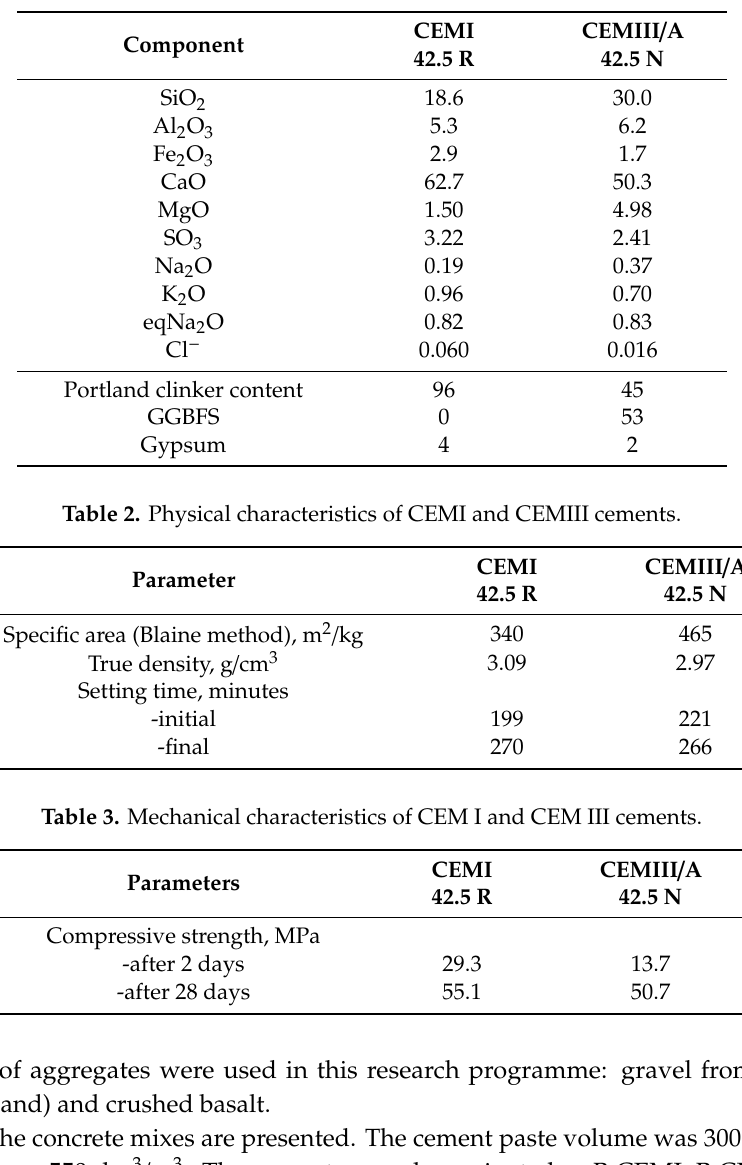
Table 1. The chemical characteristics of CEM I and CEM III cements(oxide analysis, % by mass).